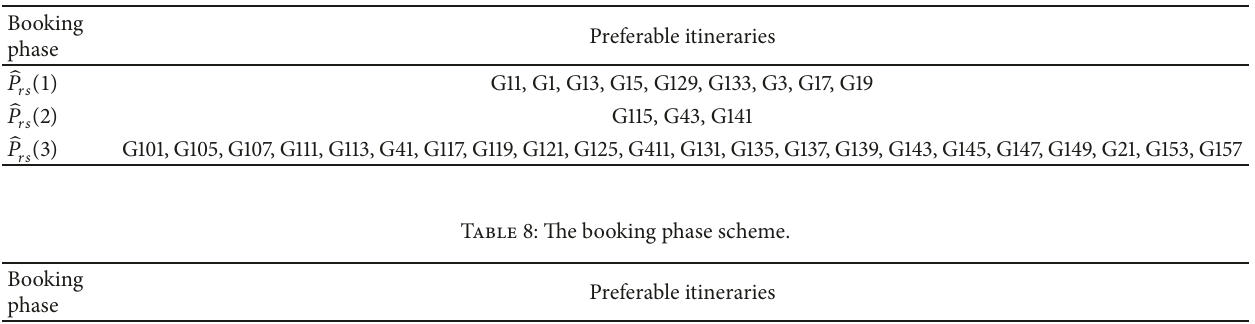
Table 7: The last booking phase scheme.